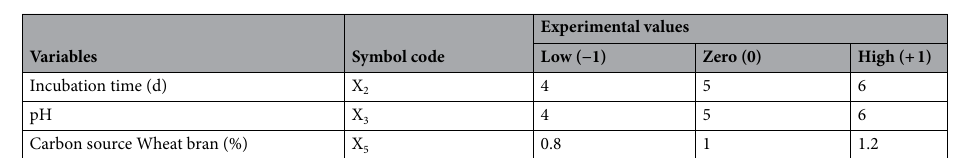
Table 3. Experimental codes and levels of independent variables in the RSM for optimal xylanase production by the Trichoderma harzianum strain.